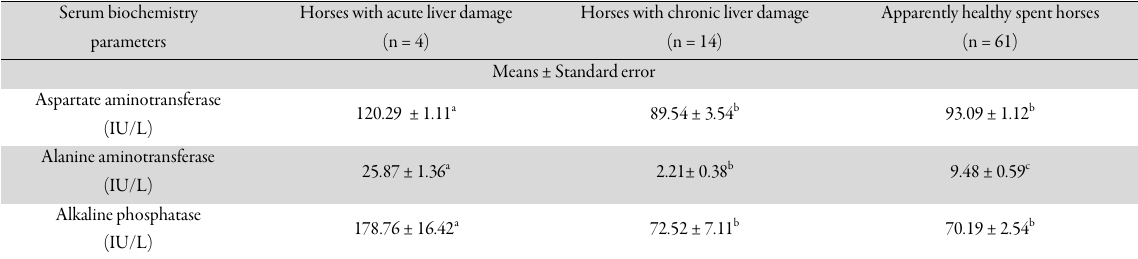
Table 1. Serum enzyme activities of spent horses with liver damage compared to apparently healthy spent horses Serum biochemistry Horses with acute liver damage parameters (n = 4) Means ± Standard